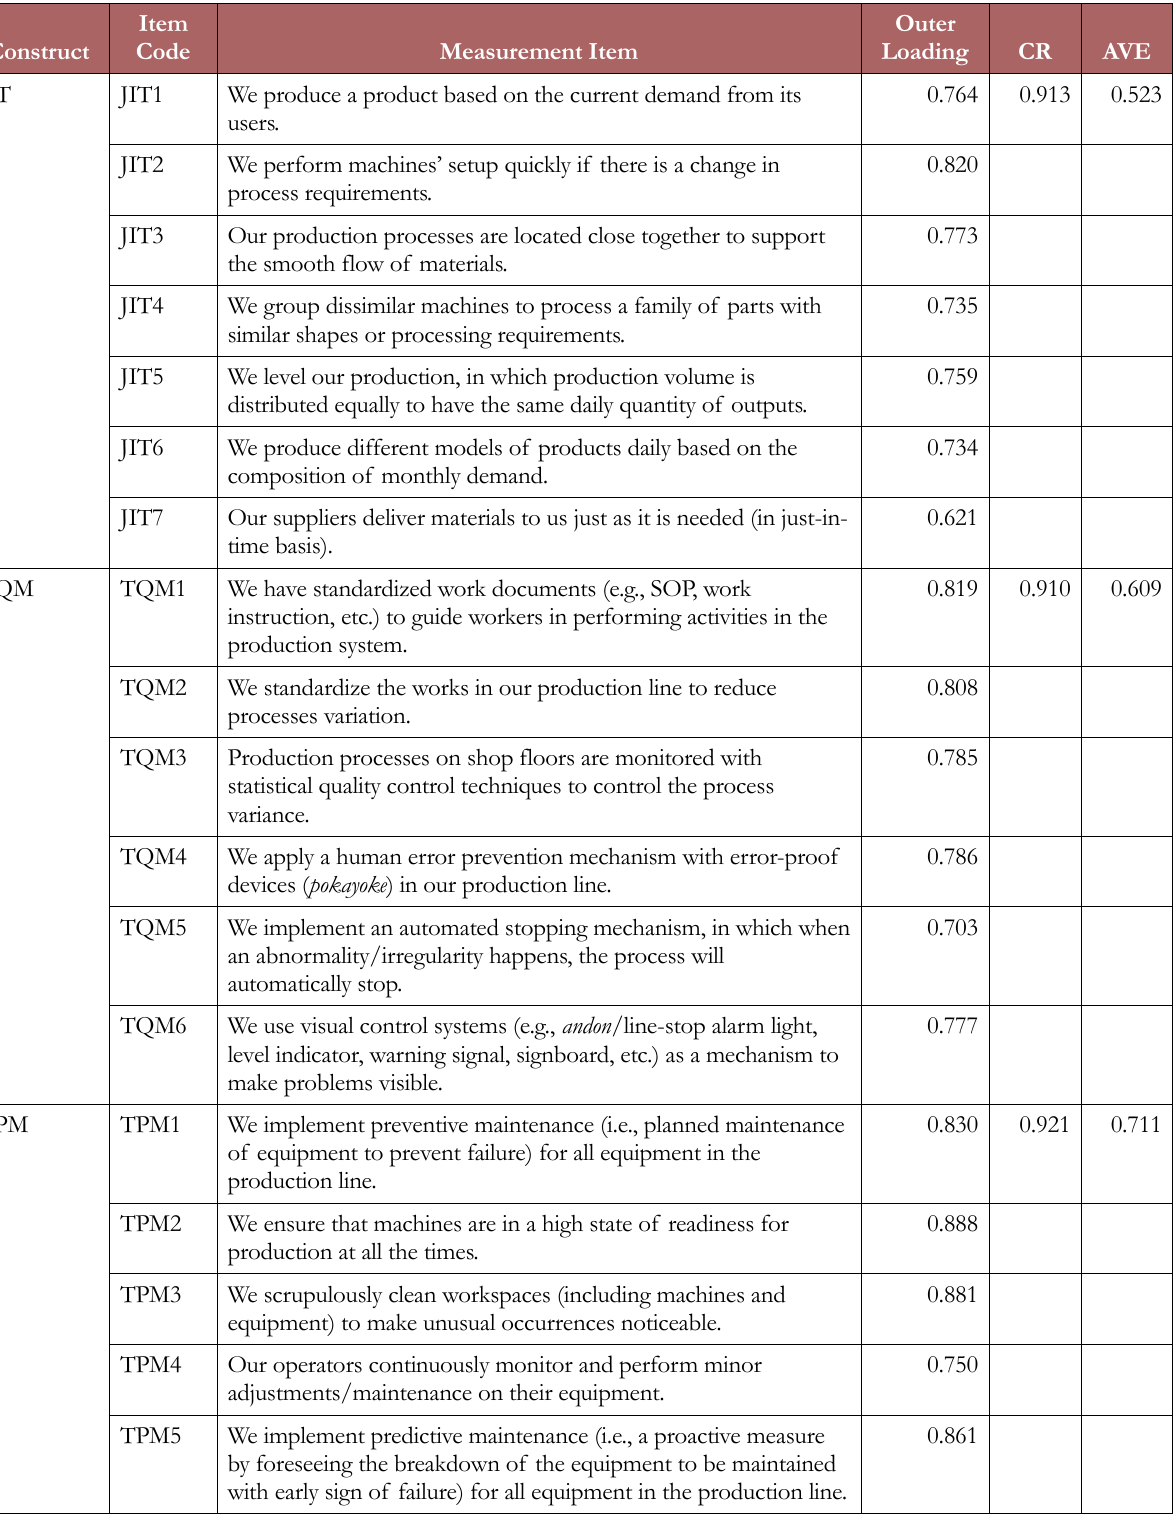
Table 4. Demographics Profile of